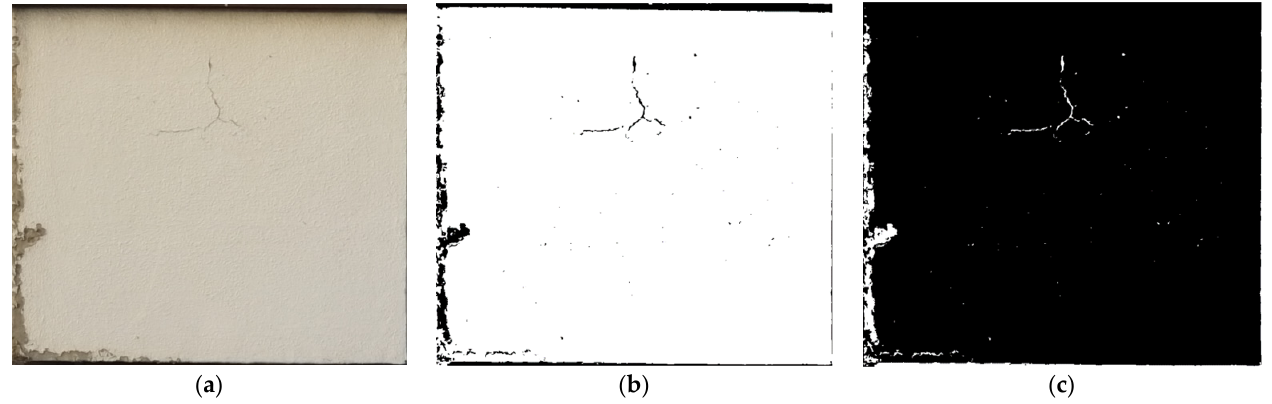
Figure 7. Raster transformation phases. ( a ) Raster with a single block model; ( b ) single raster created using cv2.adaptiveThreshold; ( c ) detection result—clearly identified crack.